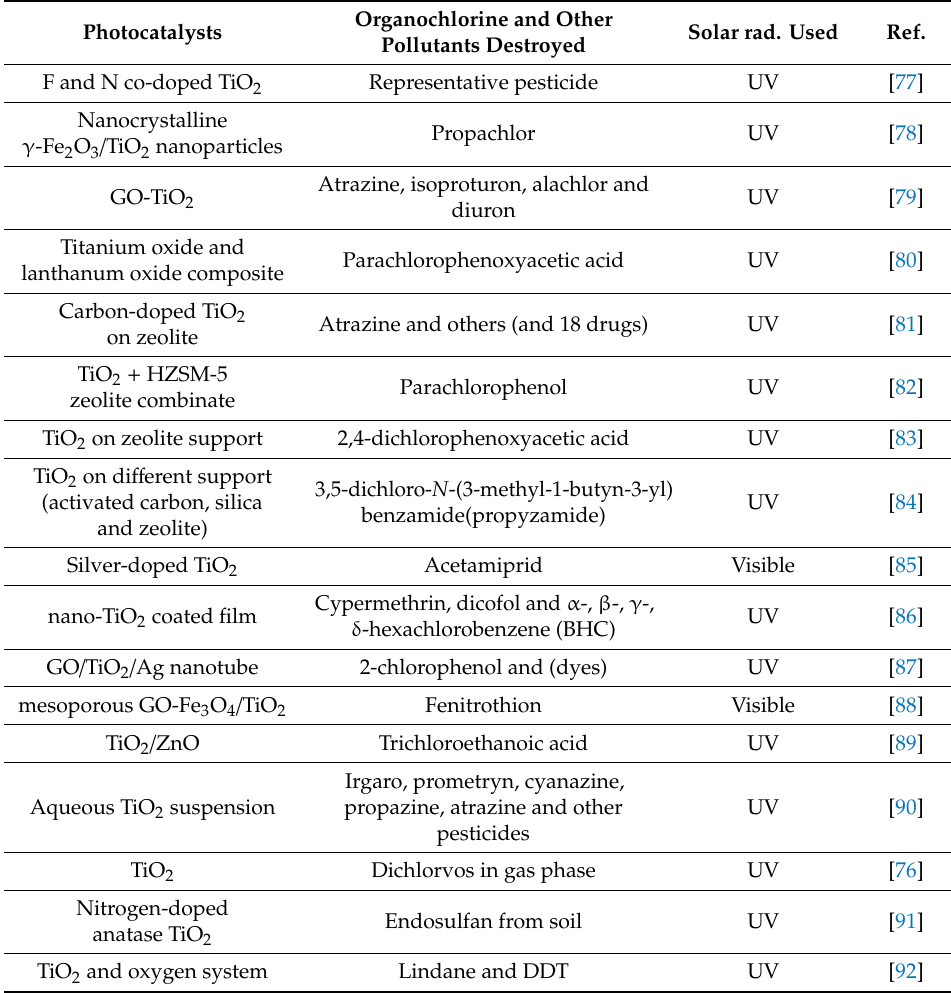
Table 2. TiO 2 -based photocatalysts and the pesticides removed.